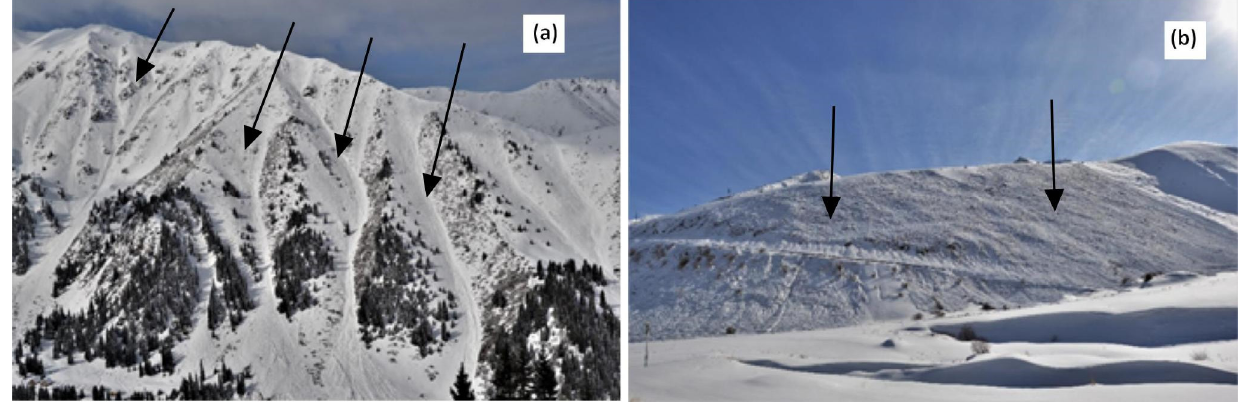
Figure 2. Avalanche paths (marked by arrows) in the Ulken Almaty valley: ( a ) channeled; ( b ) un-